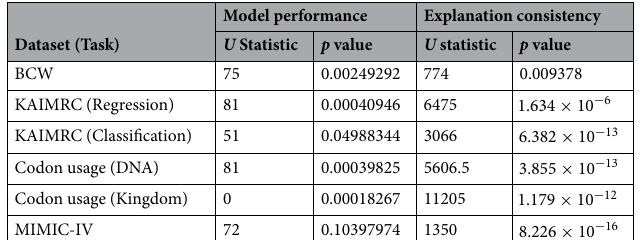
Table 6. U test statistic and p values as calculated for the differences between the model performance and explanation separability S ( a , b ) of the baseline and explanation ensemble models; a two-sided test was used.